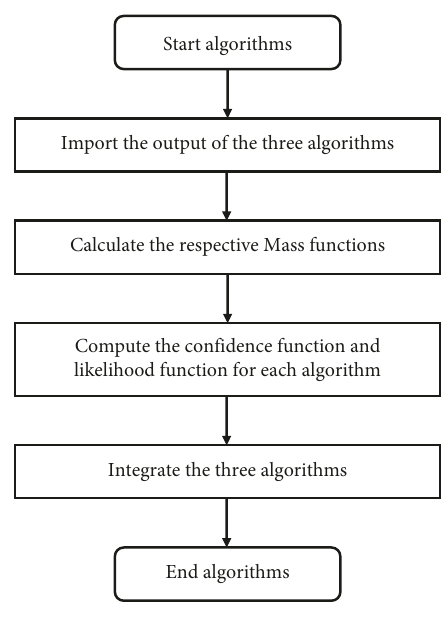
Figure 6: Integration of data mining